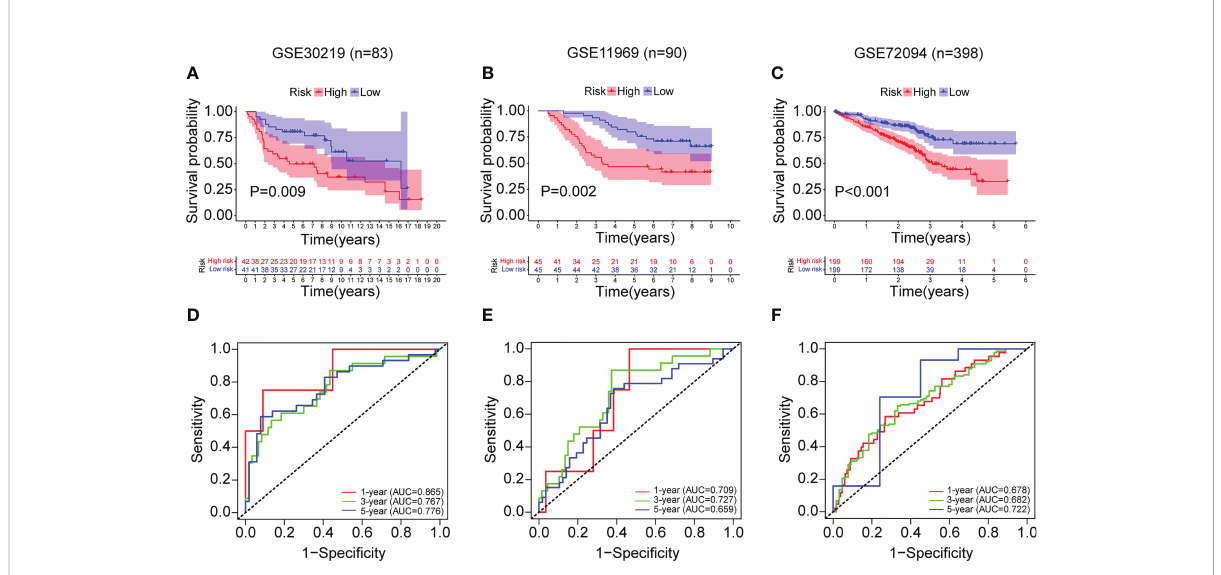
FIGURE 10 External validation of the ERS in the GSE30219, GSE11969 and GSE72094 datasets. (A – C) The Kaplan-Meier survival analysis of LUAD patients in the two risk groups divided by the ERS in the datasets of GSE30219 (A) , GSE11969 (B) , and GSE72094 (C) . (D – F) The ROC curves of the ERS for predicting the 1-, 3- and 5-year survival in the datasets of GSE30219 (D) , GSE11969 (E) , and GSE72094 (F)